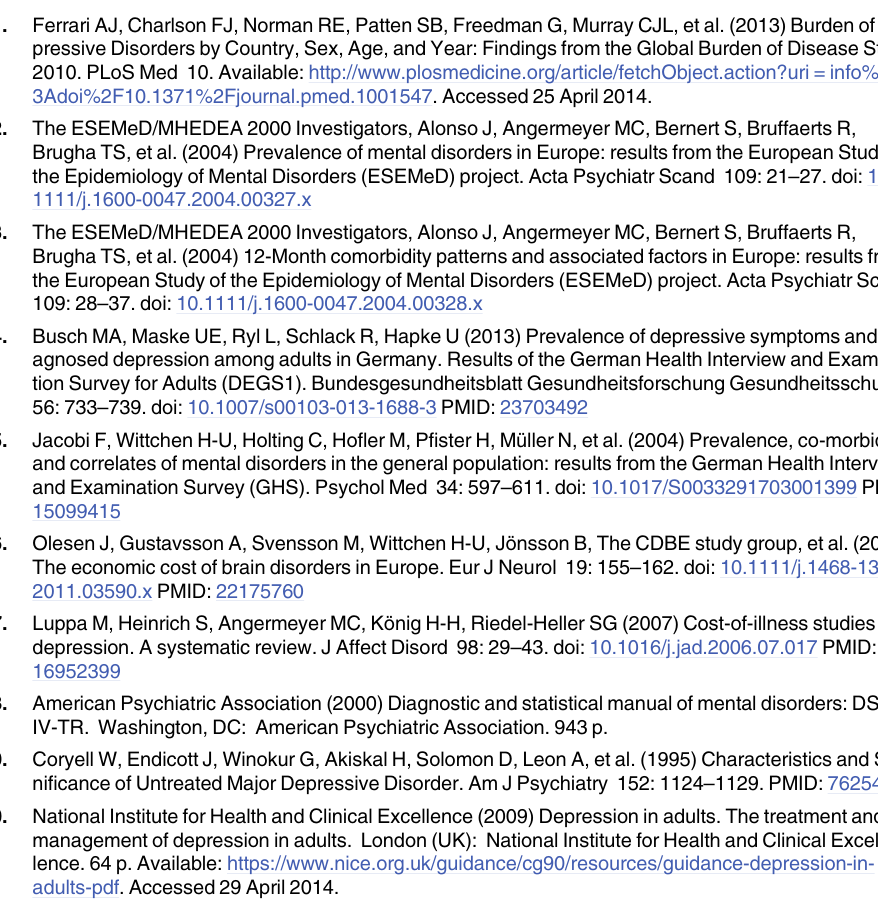
S3 Table. Intervention elements and mean costs. CLP = Chilean Pesos, § Analysis was based on two